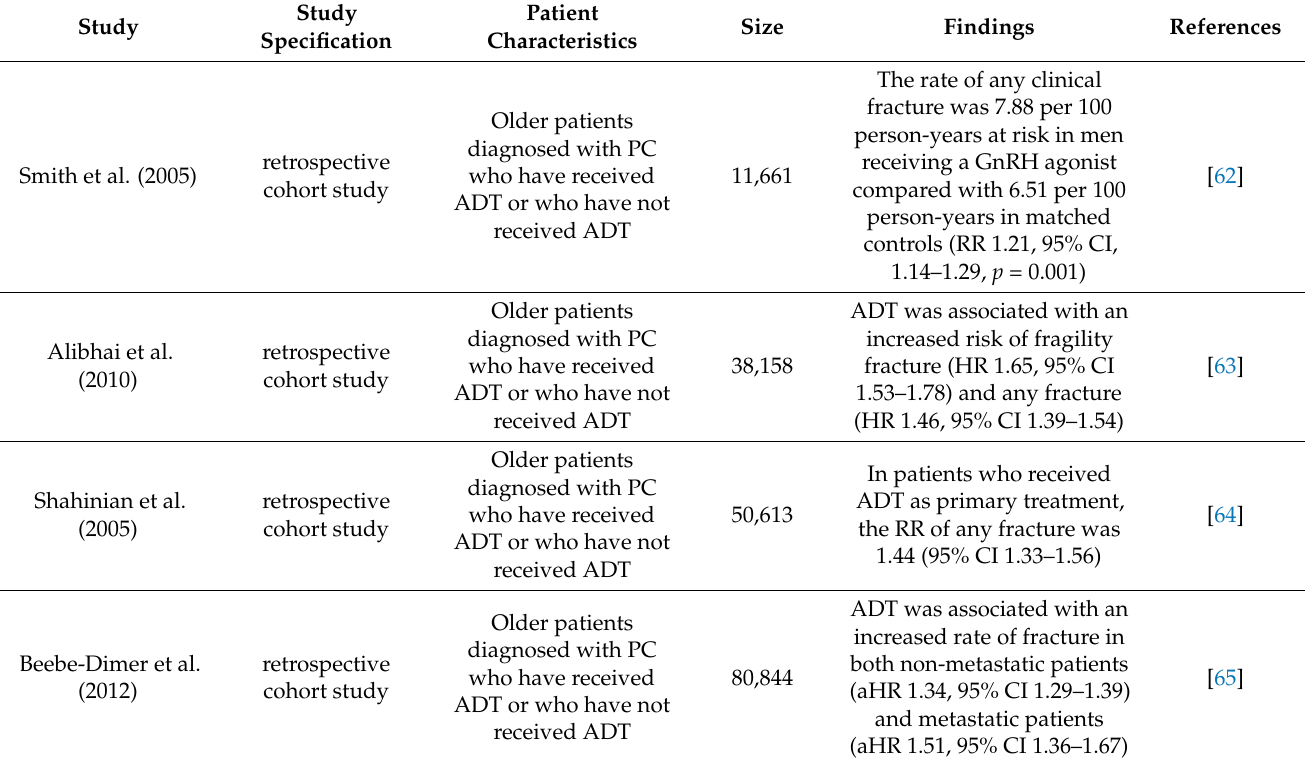
Table 5. Risk of developing osteoporosis due to ADT in older